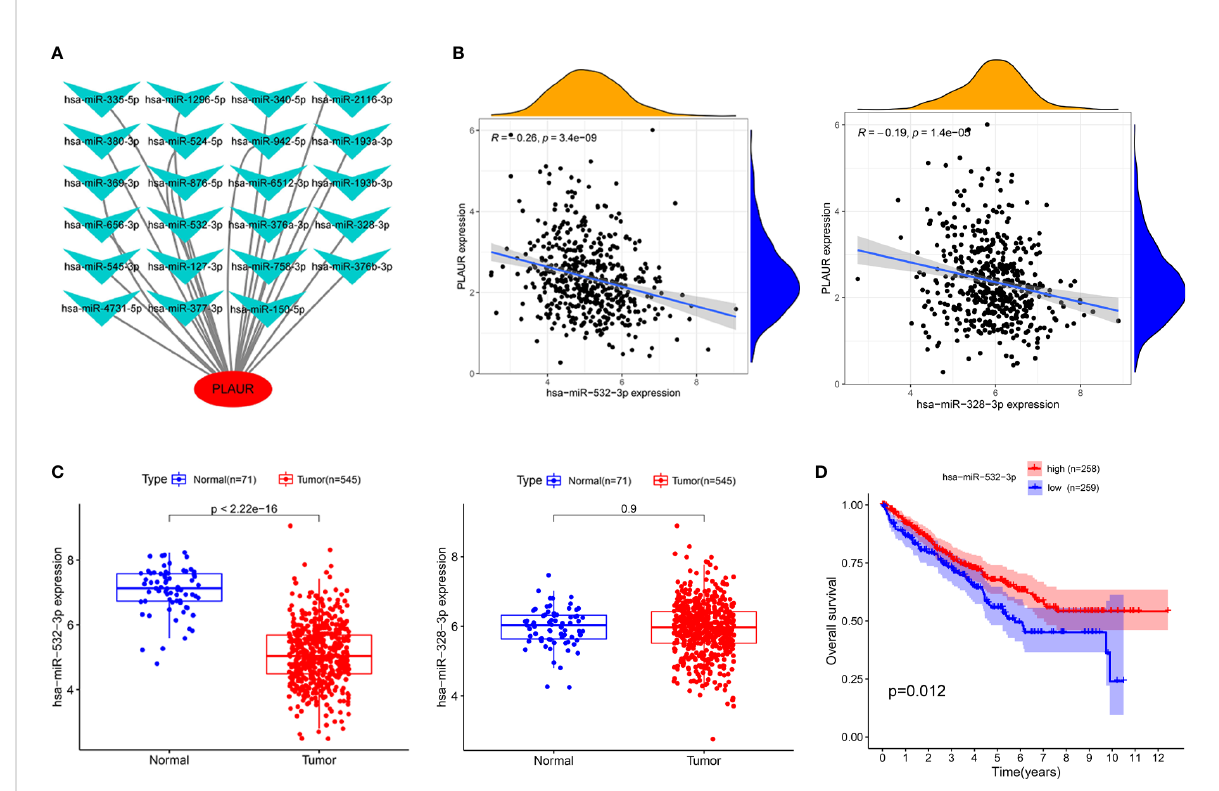
FIGURE 4 Identi fi cation of hsa-miR-532-3p as a potential upstream miRNA of PLAUR in KIRC using the StarBase database. (A) The miRNA-PLAUR regulatory network. (B) The expression correlation between hsa-miR-532-3p, hsa-miR-328-3p and PLAUR in KIRC. (C) The expression of hsa- miR-532-3p and hsa-miR-328-3p in KIRC tissues compared with normal controls. (D) The prognostic value of hsa-miR-532-3p in